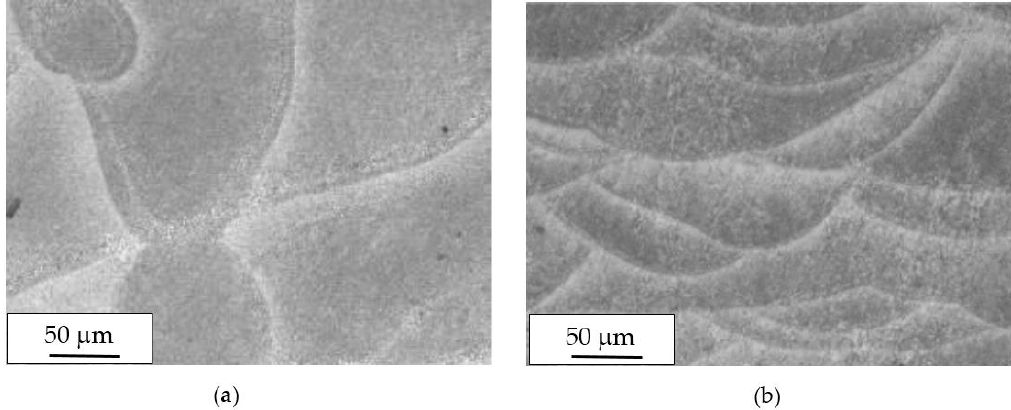
Figure 4. Optical images of microstructures of untreated (UT) specimen on ( a ) XY plane and ( b ) XZ plane.